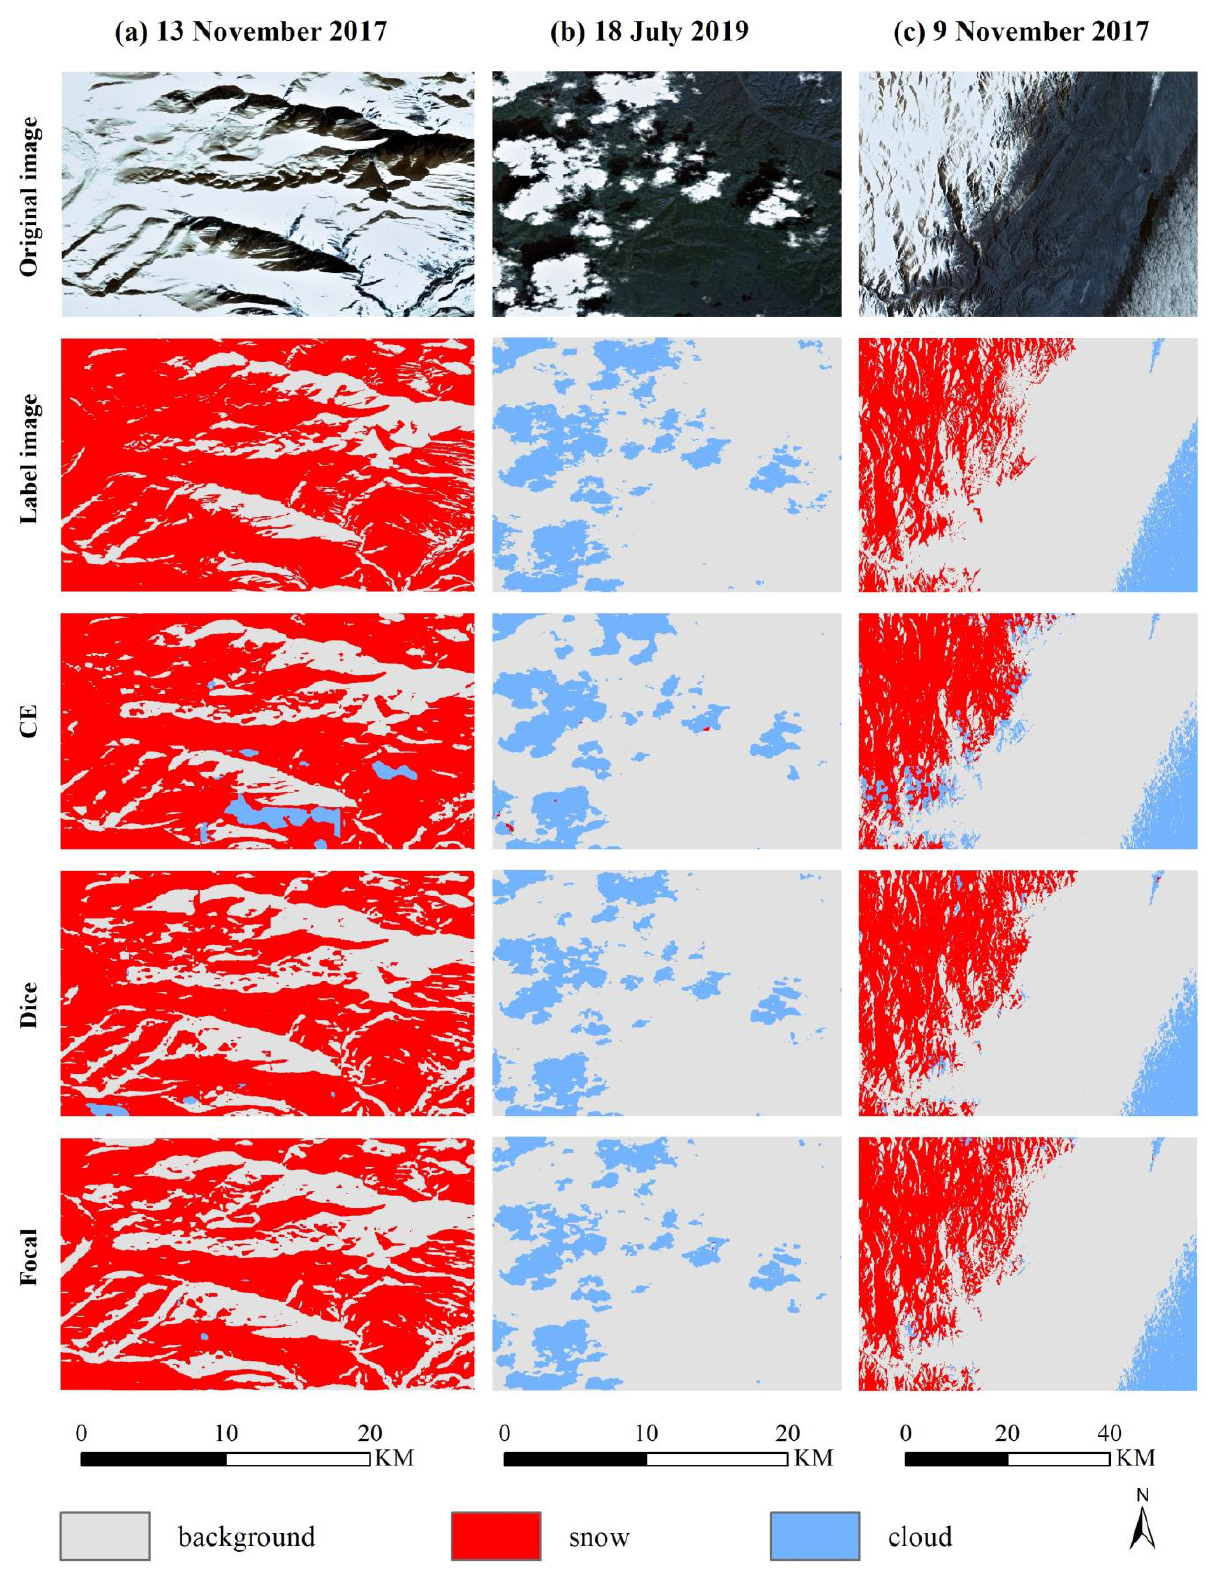
Figure 8. Comparison of cloud and snow identification under different loss functions. The three columns of subfigures ( a – c ) represent the original image, the label image, and the prediction maps under CE, Dice, and Focal loss functions at three different dates, respectively.